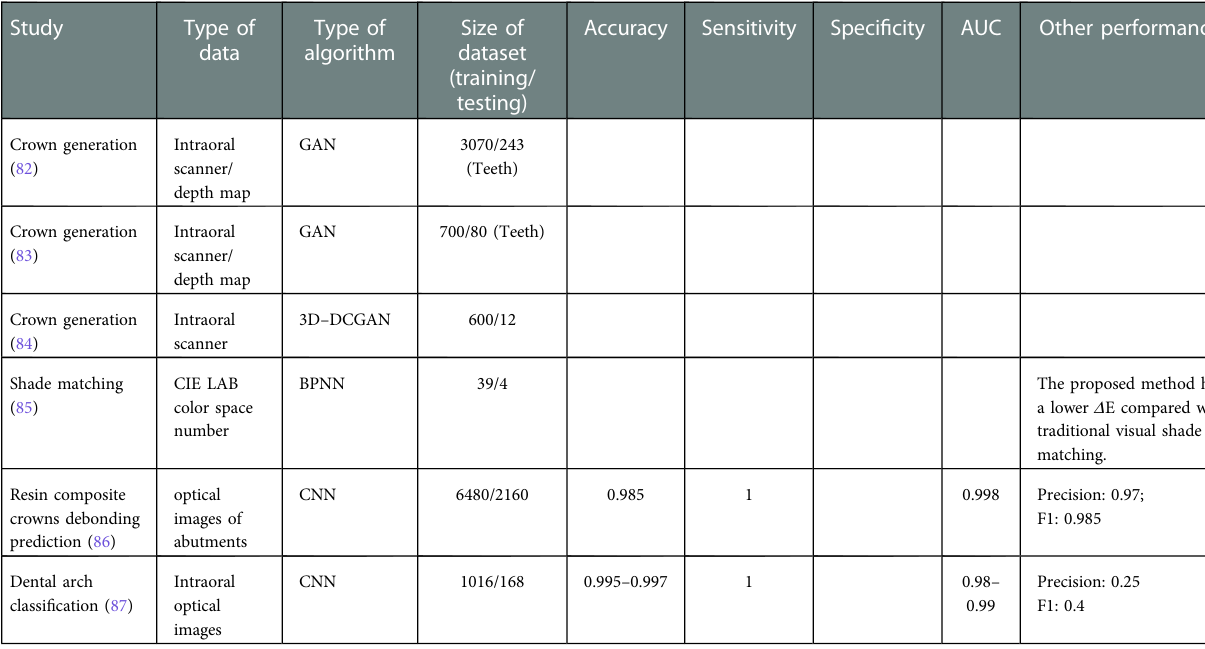
TABLE 6 Examples of AI applications in